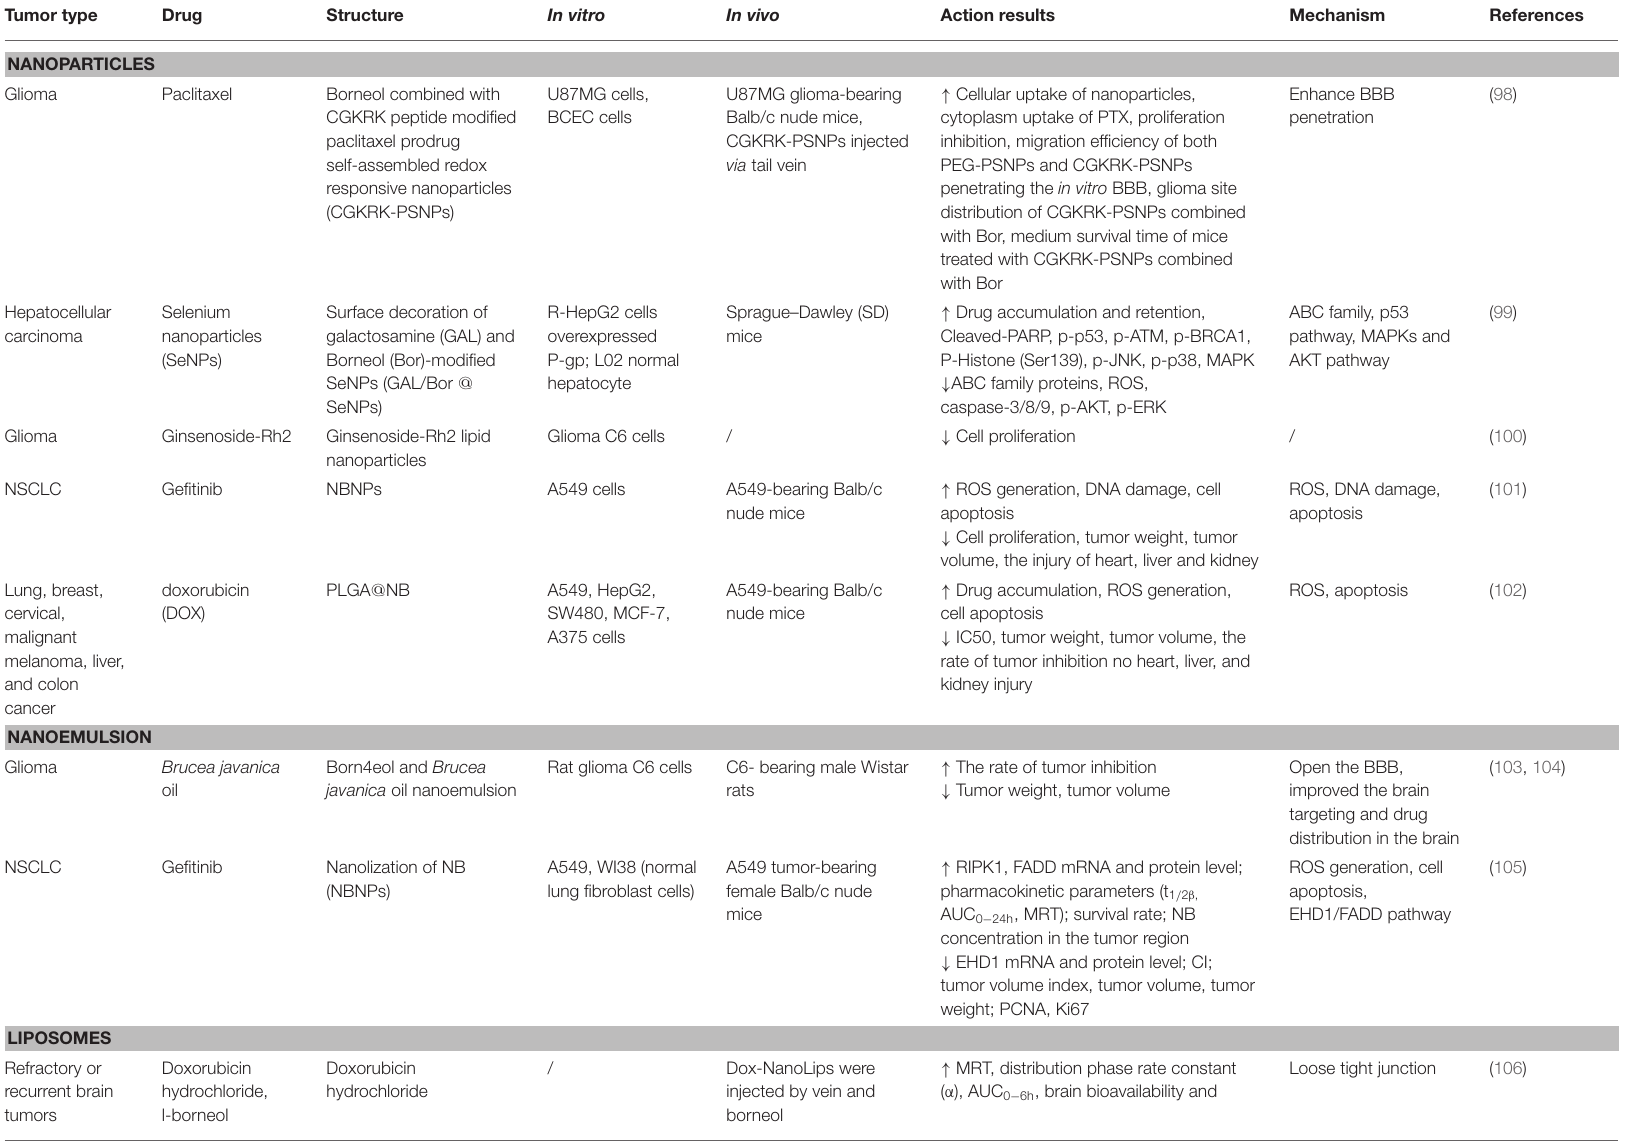
TABLE 3 | Borneol modified nanoparticle-based drug delivery